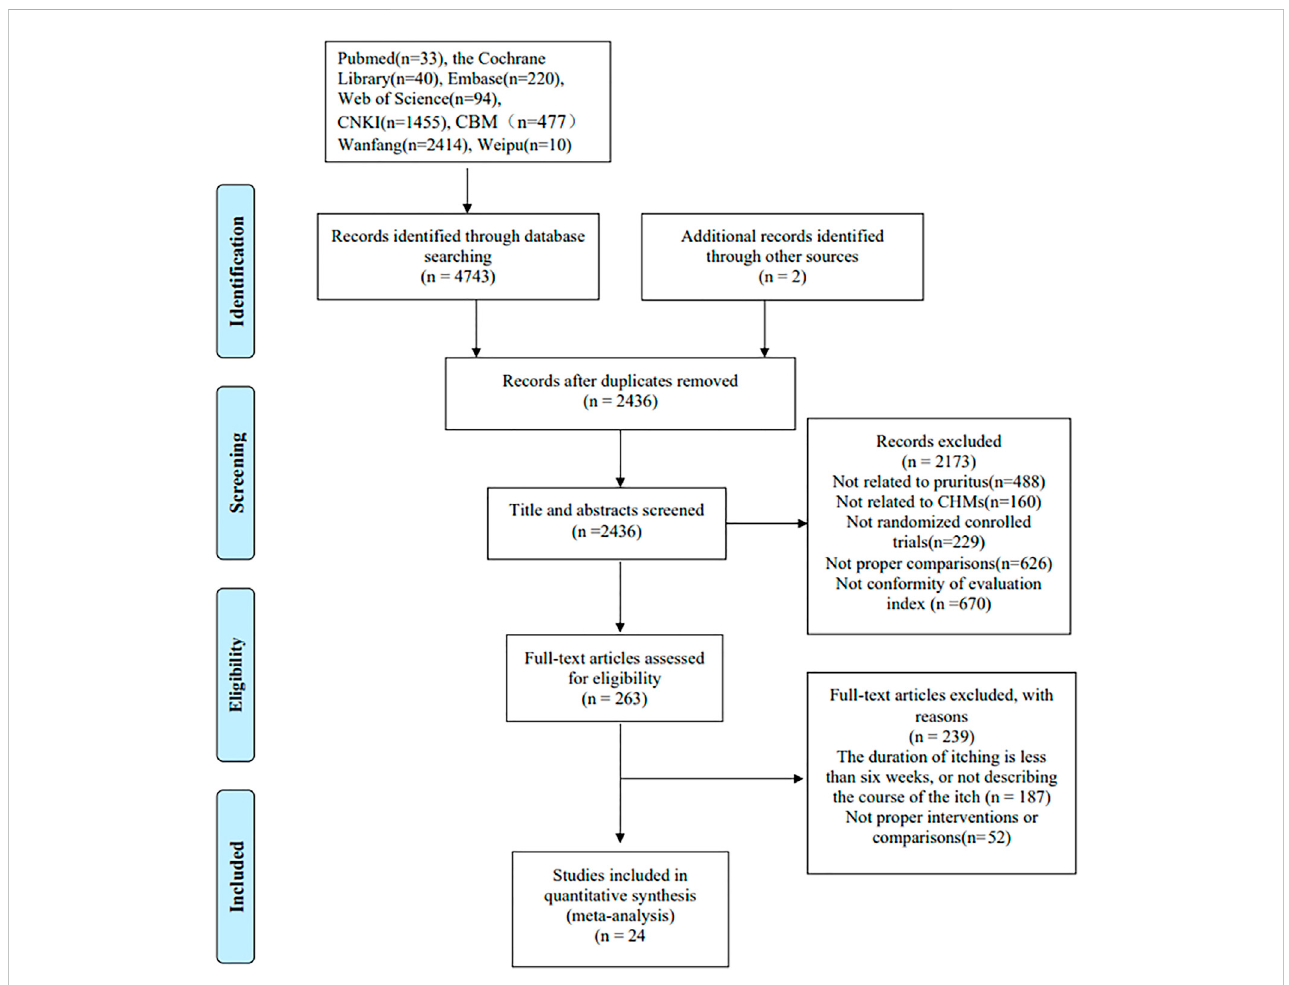
FIGURE 1 A fl ow diagram ofthestudy selection process. CNKI, China National KnowledgeInfrastructure; CBM, Chinese Biological Medicine; CHM, Chinese herbal medicine.